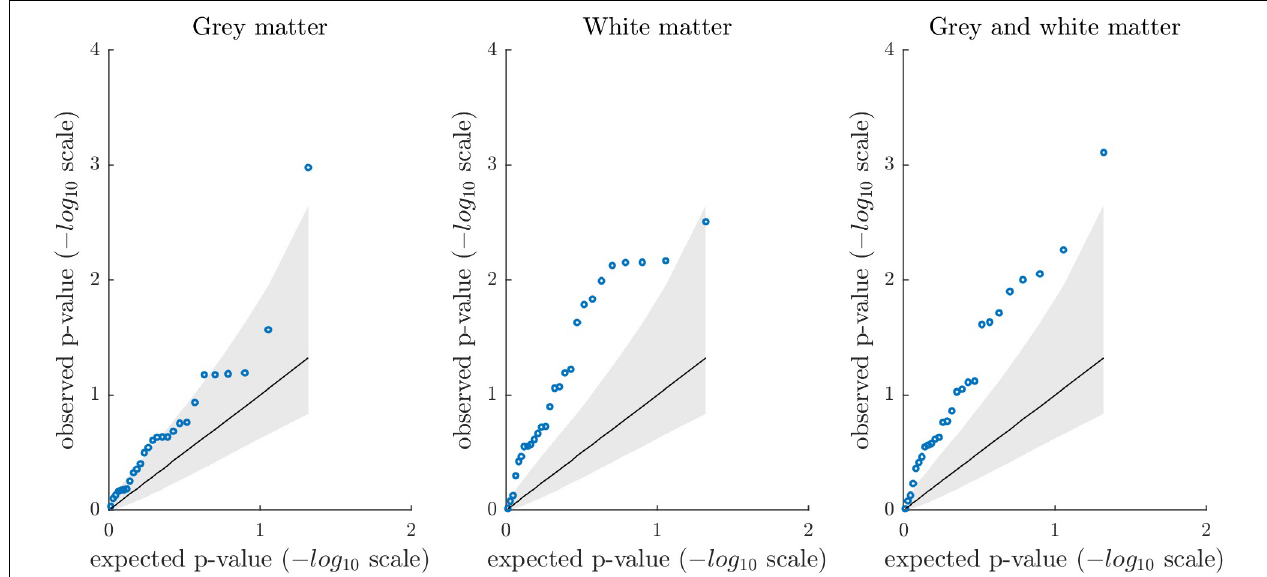
FIGURE 3 | Permutation-based quantile-quantile plots showing the distribution of observed p -values from the association analyses (blue circles) sorted from largest to smallest and plotted against the expected p -values under the null hypothesis (1 million permutations; one-tailed testing). The solid diagonal line reflects the mean expected p -values (-log10 scale). The lower and upper bound of the gray shaded area represent the 5th and 95th percentile of the expected p -values. The plots show the association results between the 27 criterion variables and gray matter, white matter, and combined gray and white matter brain age gap, respectively. Overall, quantile-quantile plots suggest that association analyses revealed stronger evidence than expected under the